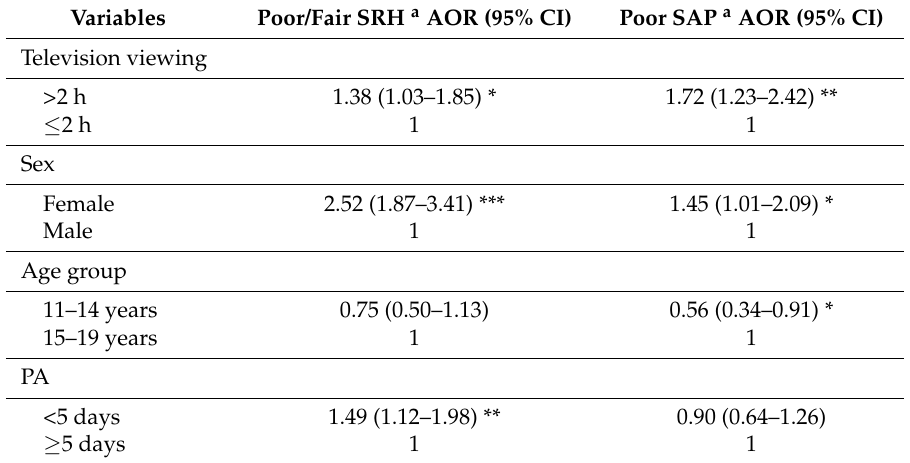
Table 5. Adjusted odds ratios of poor/fair SRH, and poor SAP for television viewing >2 h a